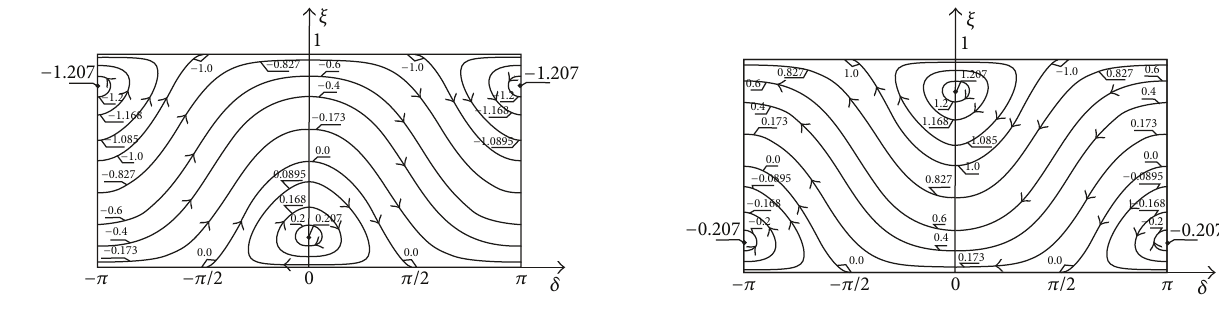
Figure 5: Phase portrait for the case of 1:1 internal resonance 𝜔 1 = (1/2)𝐾𝑏 −1 = 1 . 𝜔 2 at